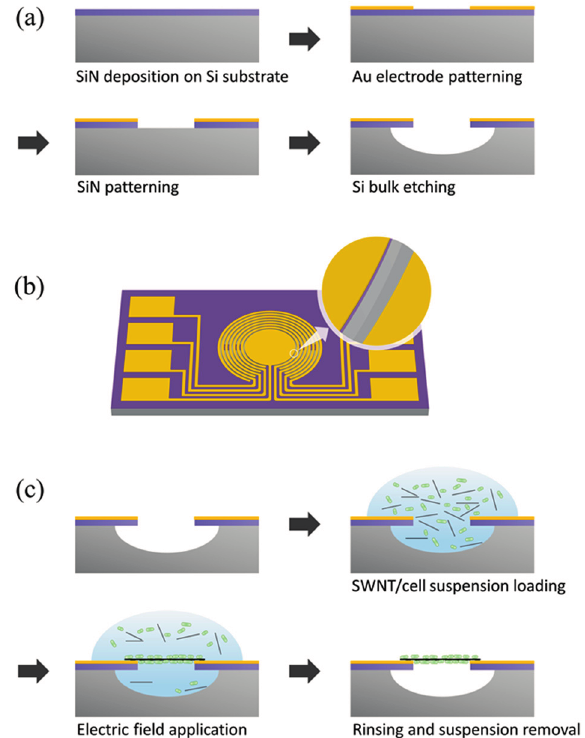
Figure 1. Device Preparation. Schematic representation for ( a ) the fabrication process of the device containing floating electrodes, ( b ) the complete device and an enlarged image of its bulk-etched gap, and ( c ) the fabrication process of E. coli -attached SWNT